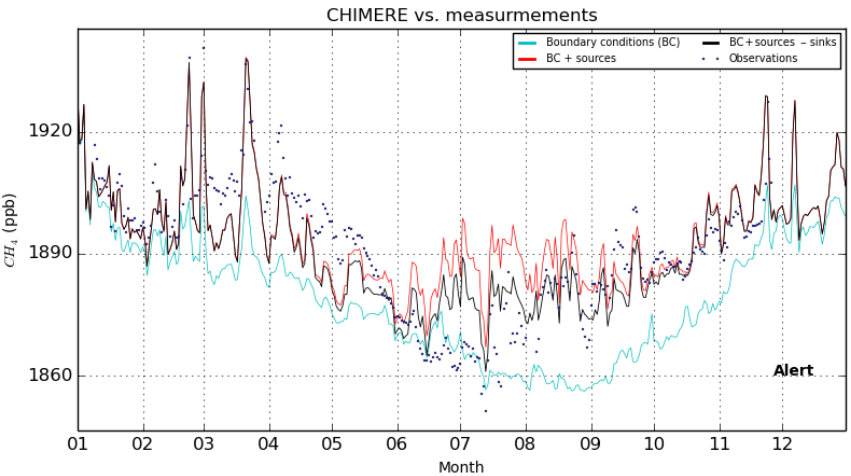
Figure 11. Time series of simulated and observed methane mixing ratios at Alert in 2012. The cyan line represents the contribution of the boundary conditions; the red line represents the added direct contribution of the sources emitting in the domain; the black line includes the three added sinks (OH, soil, Cl). The blue points represent the observations. Time resolution for simulations and observations is 1